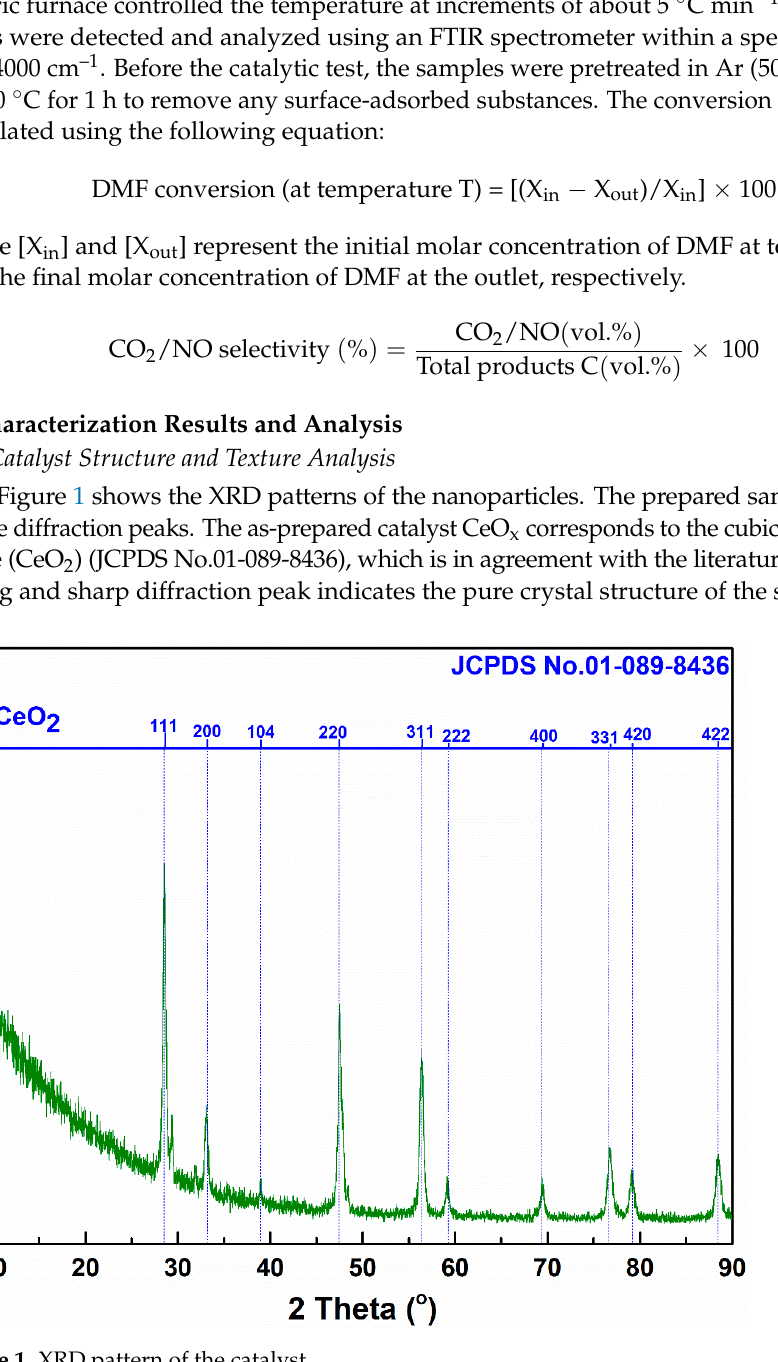
Figure 1. XRD pattern of the catalyst.